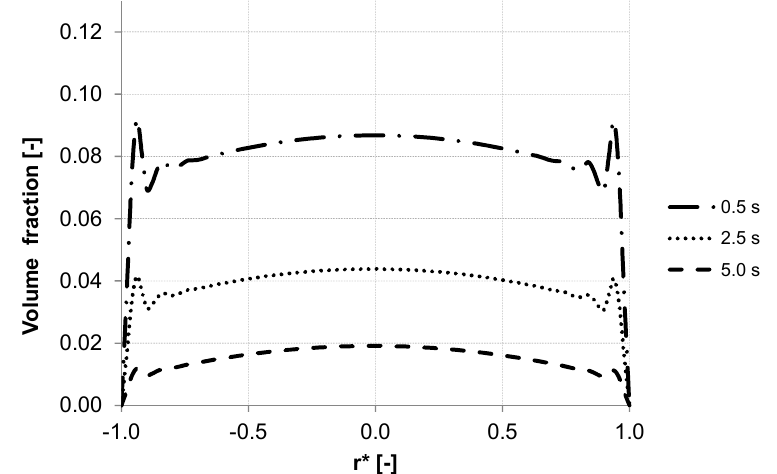
Figure 5. Particle distributions along control line A with backwashing flux of 300 L m − 2 h − 1 during 5 s (homogeneous initial distribution, particle diameter of 20